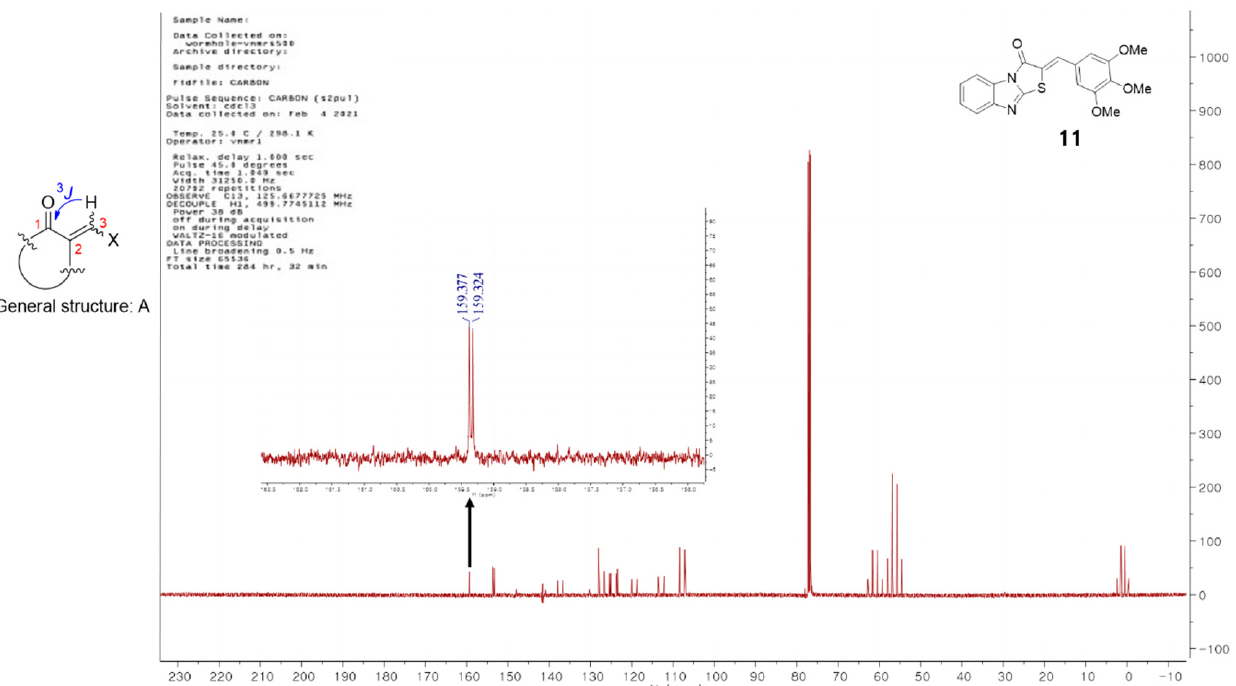
Figure 1. General structure of derivatives with trisubstituted exocyclic C, C-double bond, and the proton-coupled 13 C spectrum of compound 11 .